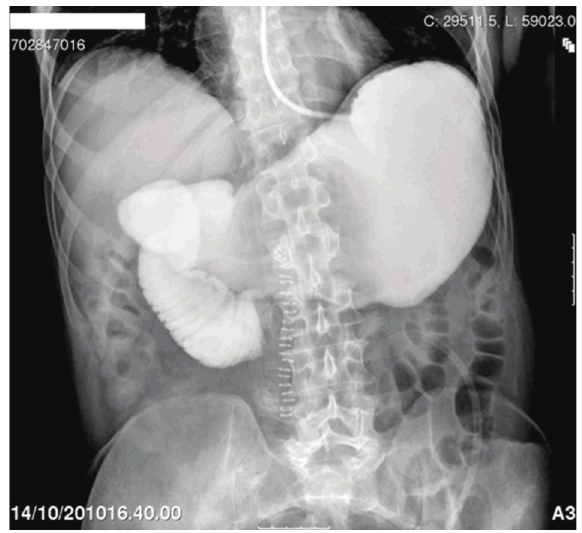
Figure 2: Coronal CT image showing duodenal clamping.